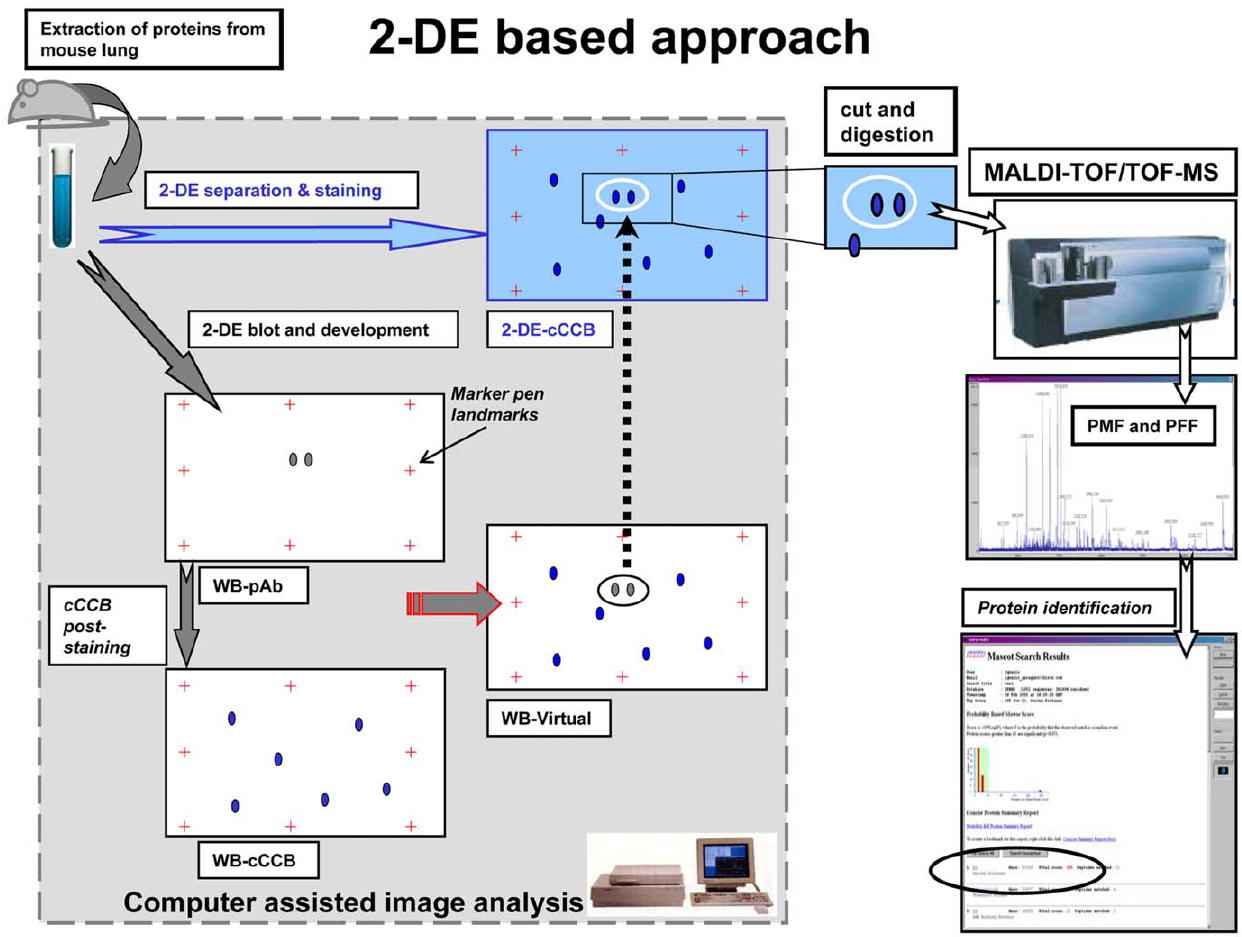
Figure 1. Description of the combined 2-DE-WB approach. 200 m g of tissue lysate protein extracts were separated on 2-DE, stained with Colloidal Coomassie G-250 and acquired as an image (2-DE-cCBB). In parallel 40 m g of total protein extract was separated by 2-DE and subsequently transferred onto PVDF membrane for incubation with antibodies directed against phosphorylated proteins. With a marker pen, landmarks points (crosses in Figure) were set around the membrane and the image of phosphorylated proteins was acquired (WB-pAb). Subsequently, the total proteins on the same membrane were revealed by cCCB-post staining and the image was recorded (WB-CBB). Using the marker added landmarks the two images were superimposed and combined by the image analysis software to create a virtual image showing the phosphoproteins and the total proteins together (WB-virtual). Several protein spots from this image, which are in common with the cCBB-2-DE image, were selected as additional landmarks and used to superimpose the WB-CCB image to the 2-DE-cCBB image. This allowed deciphering of phosphorylated proteins on the gel. Highlighted spots were then excised from the gel using a spot cutter, followed by in-gel digestion using trypsin. The proteins were identified using MALDI-TOF